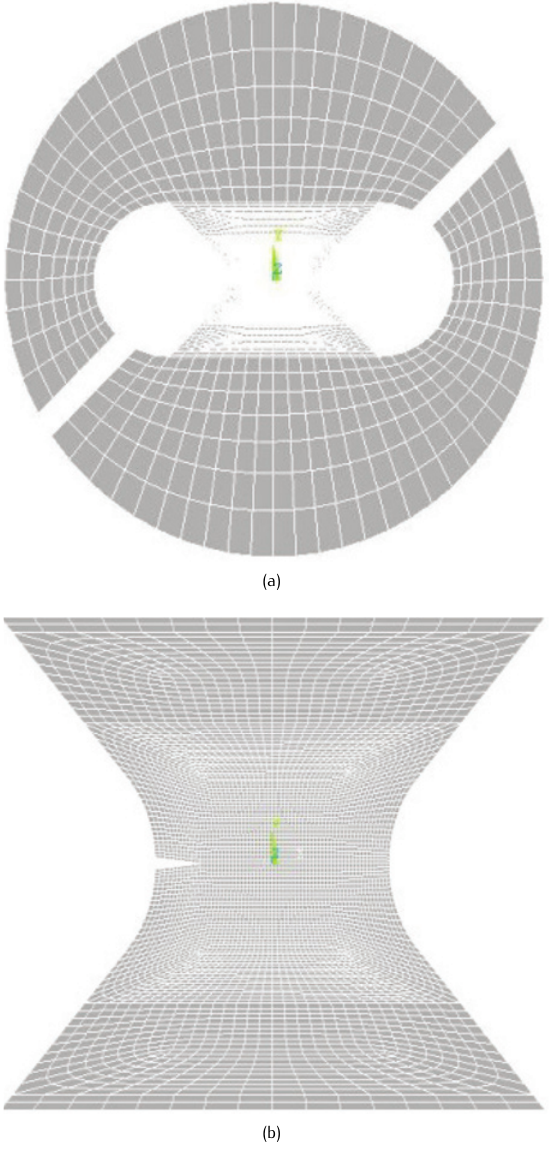
the external loads slowly and integrating the dynamics Figure 5. The mesh distribution for Arcan fixture and the equations until the all significant transients have died out. Figure 5: The mesh distribution for Arcan fixture and the specimen